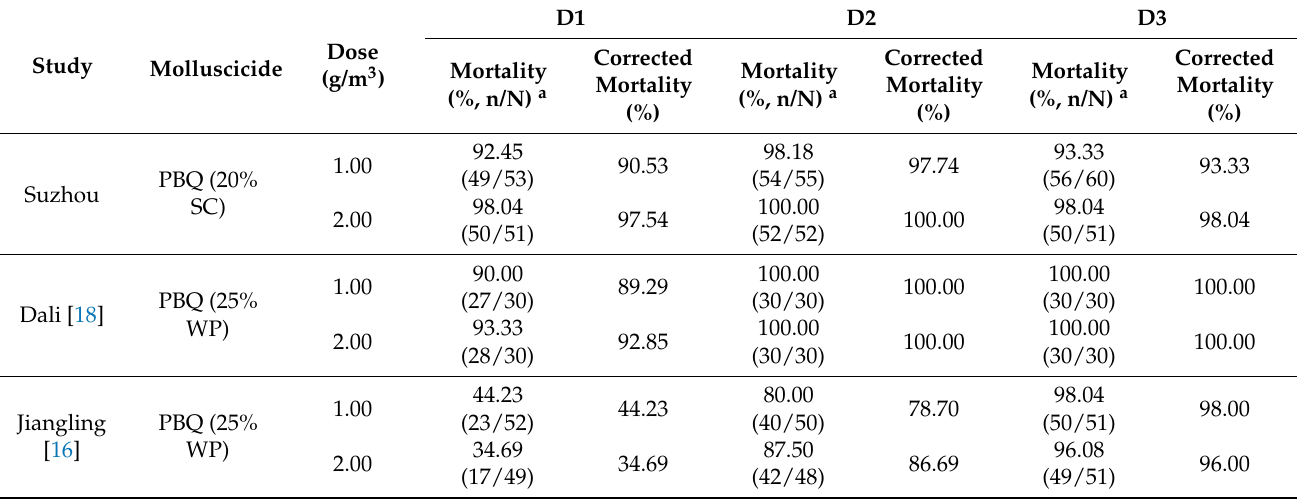
Table 2. Molluscicidal effect of different dosage forms of PBQ in ditch experiments.